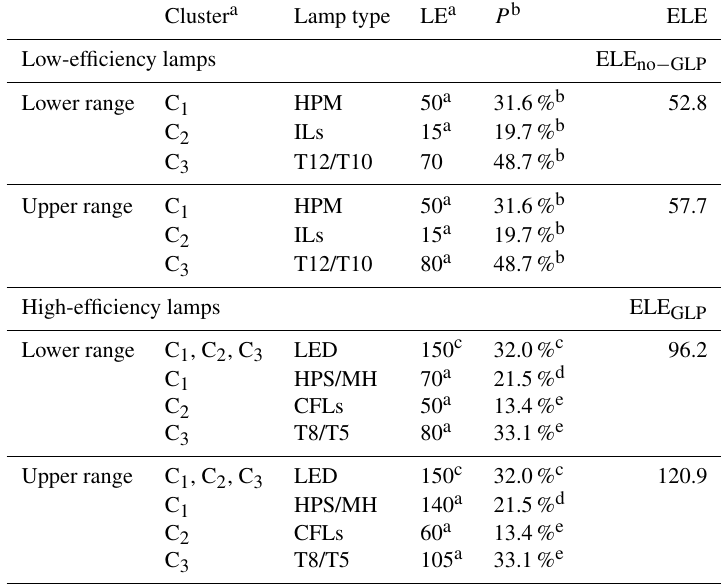
Table 1. Effective luminous efficacy (ELE) with and without the GLP. Cluster a Lamp type LE a P b ELE Low-efficiency lamps ELE no − GLP Lower range C 1 HPM 50 a 31.6% b ILs